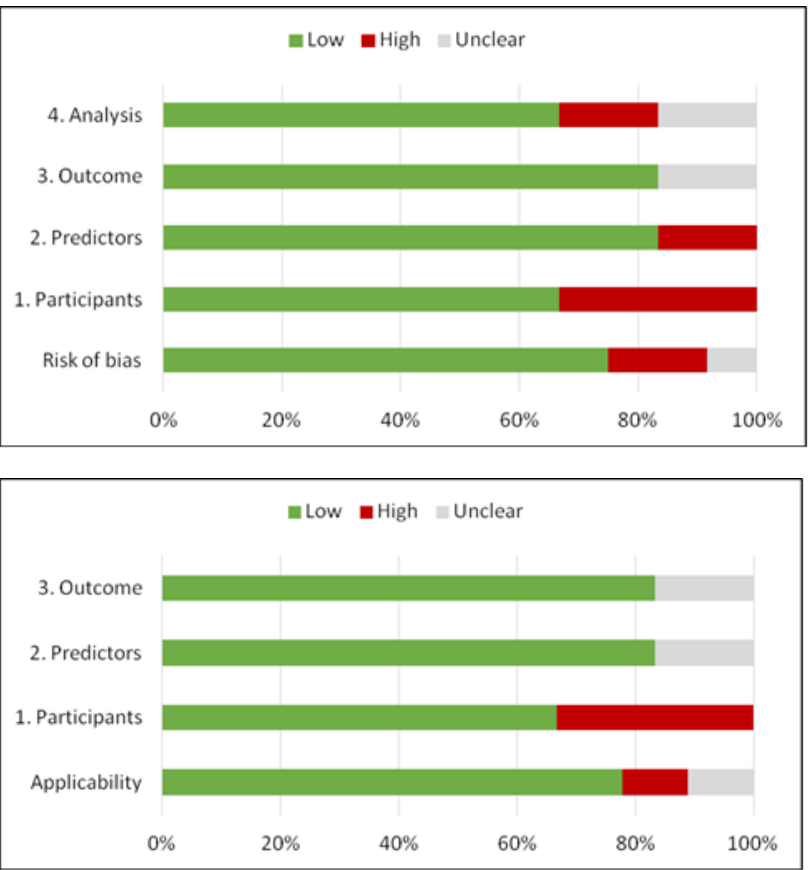
Figure 2. Adherence rate of the RQS of the included studies according to RQS key domains.